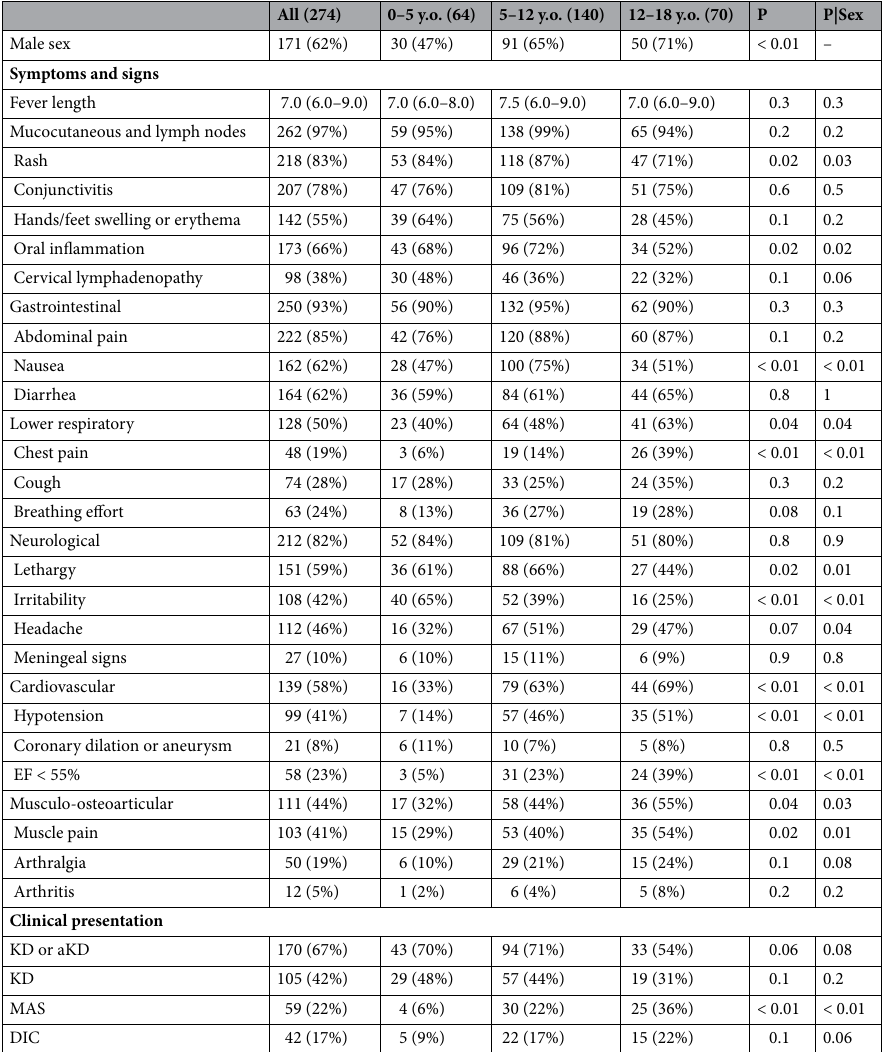
Table 3. Demographic and clinical characteristics of MIS-C cohort respective of age. Binary data given as count (per-cent), and numerical data as median (interquartile range). BMI body mass index, DIC disseminated intravascular coagulation, EF ejection fraction, KD Kawasaki disease, MAS macrophage activation syndrome, MIS-C multisystem inflammatory syndrome in children, y.o. years old, P|Sex sex-adjusted p-value. Hypotension defined as minimal SBP in mmHg less than 70 + 2 × age in years or 90 for children over 10 years